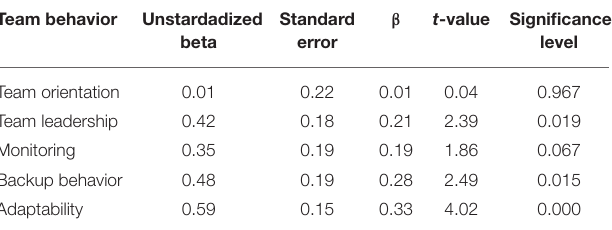
TABLE 4 | Unstandardized and standardized coefficient ( β ), standard error, t -values, and significance levels for situation awareness regressed upon coordinating mechanisms.